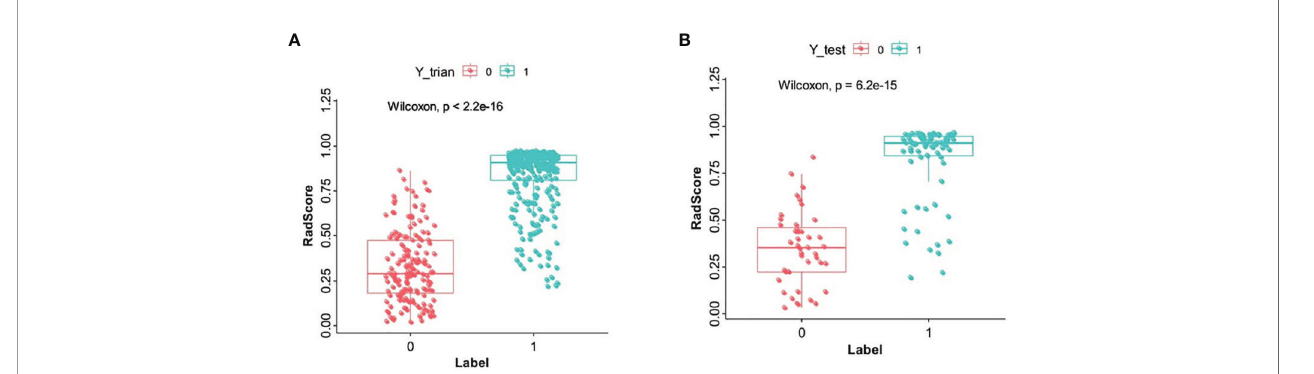
FIGURE 3 | The boxplot of RadScore from the training set (A) . The boxplot of RadScore from the validation set (B) .